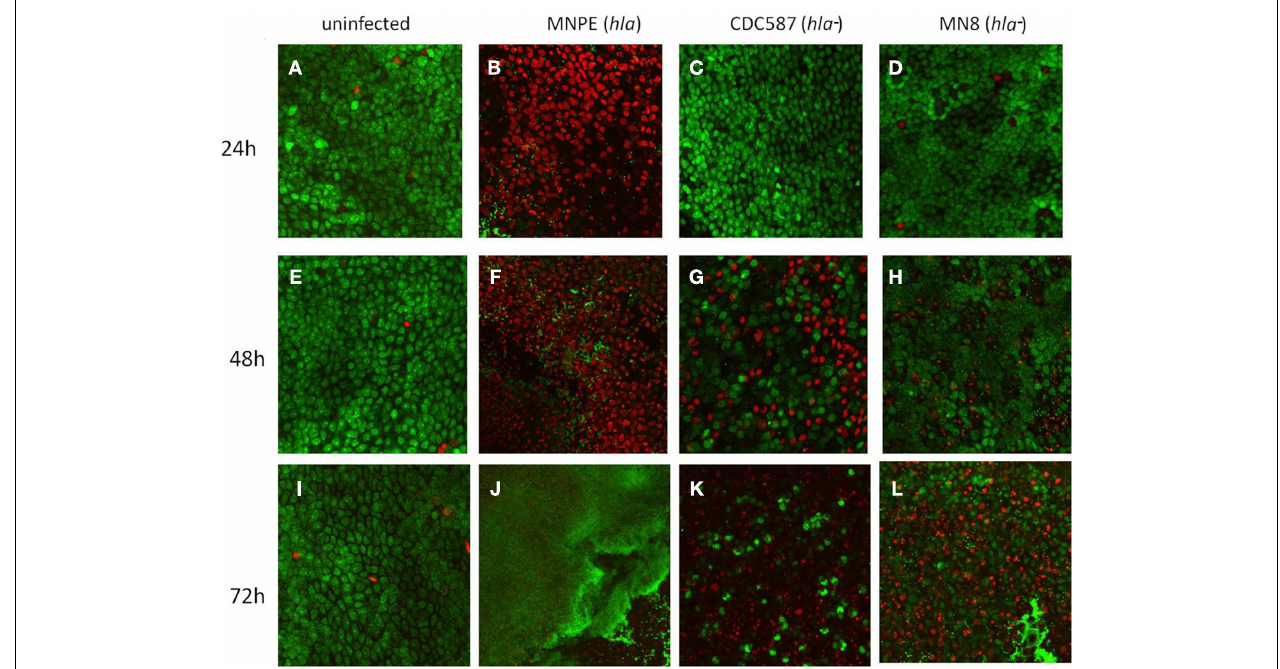
contrast, the tissue infected with CDC587 or MN8 resembles uninfected tissue at 24h. (F) At 48h, more bacteria are evident in the MNPE-infected tissue. (G,H) Some of the tissue infected with CDC587 or MN8 has died (red) and sloughed away (black). Small, individual cocci (small, bright green punctuate staining) are beginning to appear. (J) At 72h, MNPE biofilm (diffuse green) has overtaken the tissue. (K) At 72h post-infection, most of the tissue has been killed by CDC587, very few cocci are observed. (L) At 72h post-infection with MN8 results in ∼ 50% cell death (red/black areas). Some macro-colonies are beginning to form in the lower right quadrant. Original magnification was 60 ×